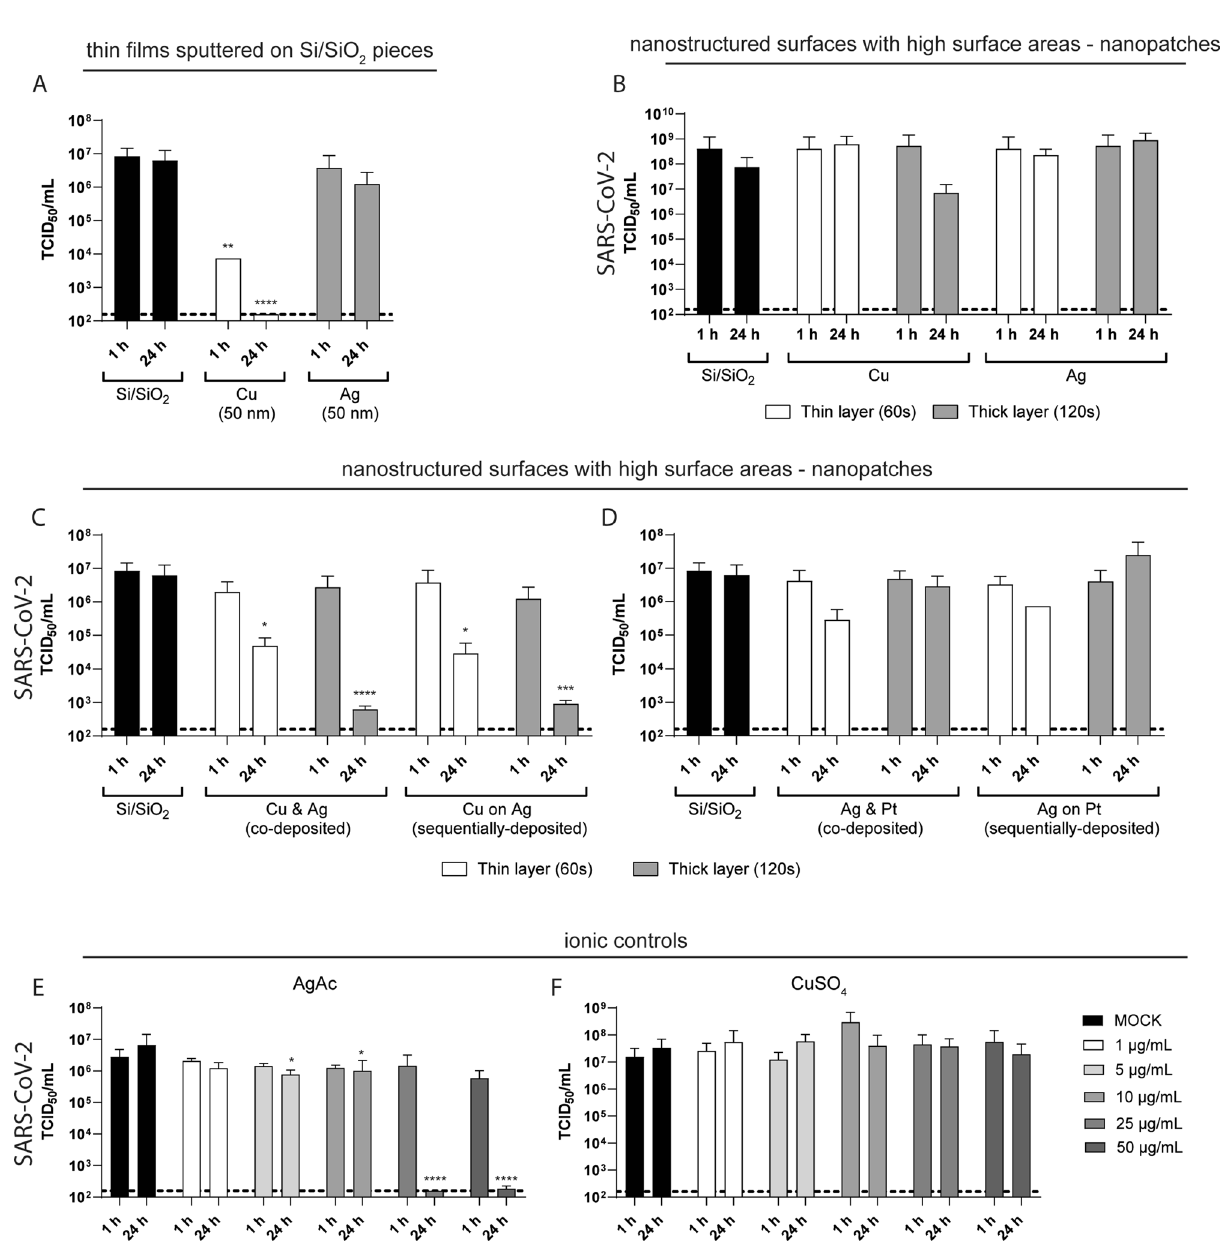
Figure 5. Results of antiviral activity for ( A ) Cu and Ag thin films sputtered on Si/SiO 2 pieces or ( B – D ) nanopatches sputtered on Si/SiO 2 which were incubated with SARS-CoV-2 for indicated time periods. ( E – F ) Silver acetate (AgAc) and copper sulfate (CuSO 4 ) solutions, used as ionic controls, were spiked with SARS- CoV-2 an incubated for similar time periods. Residual infectious virus was quantified by TCID 50 calculation. Dotted line indicates the lower limit of quantification. Data are expressed as mean ± SD of three independent experiments. Asterisks (*) indicate significant differences (* p < 0.05; ** p < 0.01; and *** p < 0.001) compared to MOCK (untreated control) or Si/SiO 2